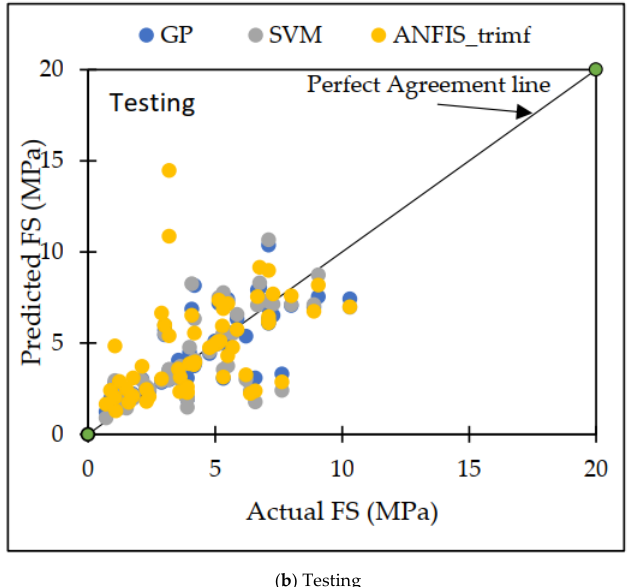
Figure 9. The scatter plot shows observed and predicted values of FS from SVM, GP, and ANFIS.